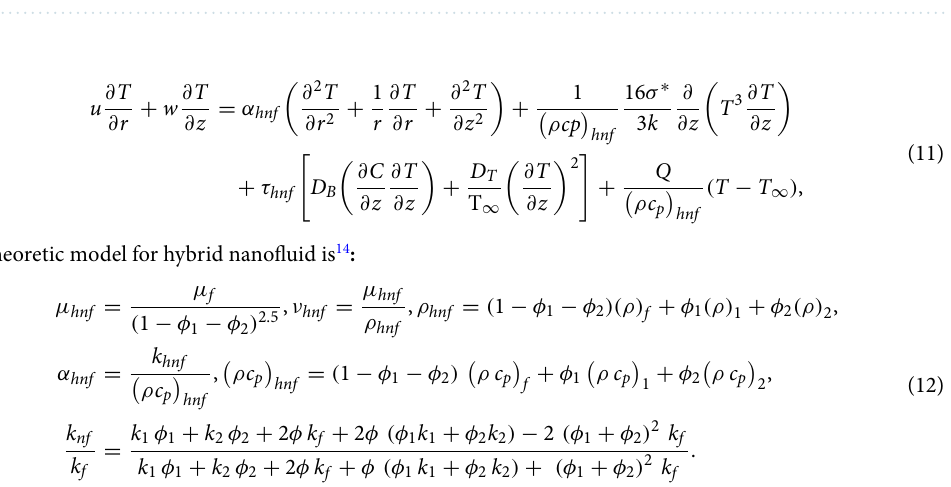
Table 1. Thermo physical features of nanoparticles and water 15